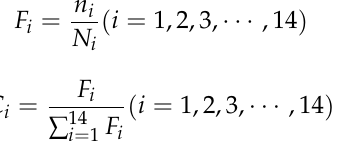
Figure 7. Do they have specific meanings that need explanations? If it is not, please confirm. If it needs, please revise.